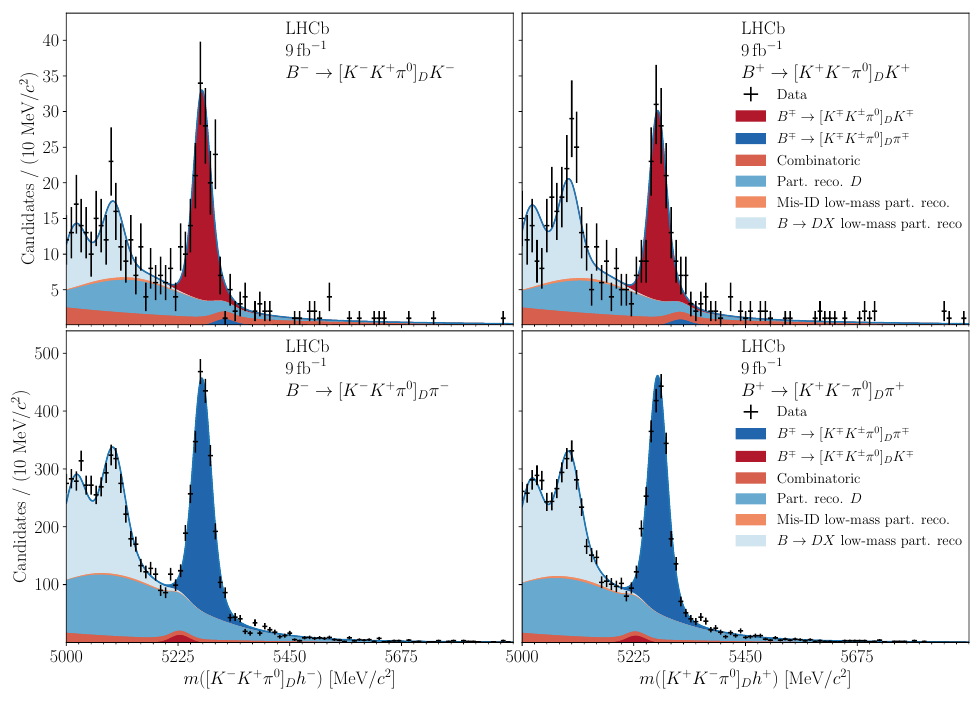
Figure 4 . Mass distributions of B ∓ → [ K ± K ∓ π 0 ] D K ∓ (top) and B ∓ → [ K ± K ∓ π 0 ] D π ∓ (bottom) candidates, separated by